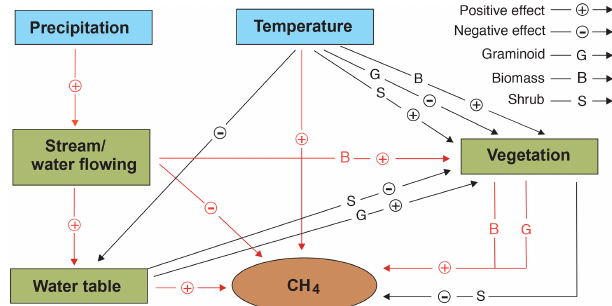
Figure 7. Schematic illustration showing the potential independent and interactive impacts of precipitation, temperature, vegetation, and hydrology on methane (CH 4 ) fluxes in northern peatlands. Ar- rows in red and black are derived from this study and previous stud- ies respectively (e.g. Mäkiranta et al., 2018; Roulet et al., 1992; Yavitt et al.,